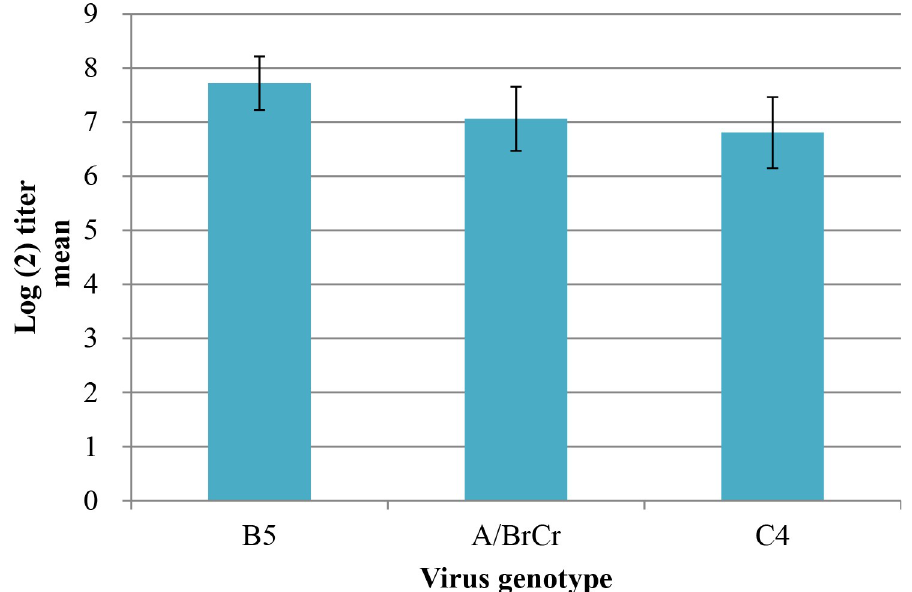
Fig 1. Cross-reactive neutralizing antibody titers in post-infection children sera against EV71 viruses isolated in Vietnam.